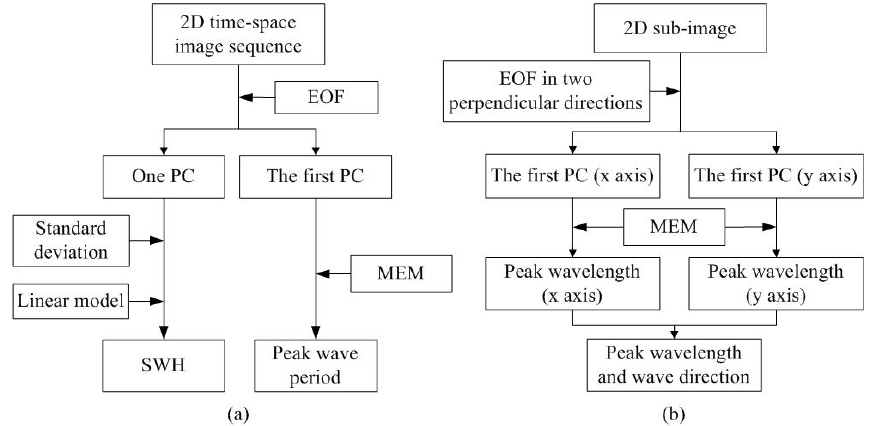
Figure 12. Basic steps of the empirical orthogonal function (EOF)-principal component (PC)-based algorithm for: ( a ) H S and peak wave period; ( b ) peak wavelength and wave